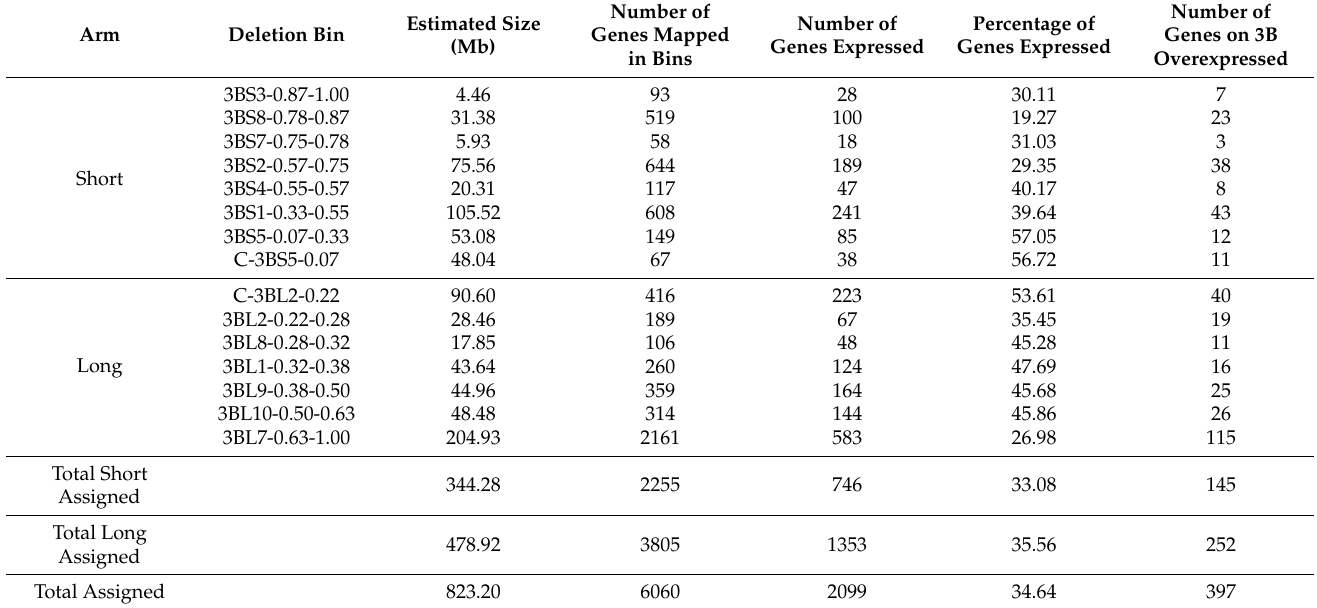
Table 2. Results of expression for the genes assigned to chromosome 3B. Number of genes expressed during meiosis assigned to the different deletion bins of chromosome 3B. Estimated size (Mb): estimated size of each deletion bin; Number of genes mapped in bins: Total number of high confidence (HC) genes mapped per bin; Number of genes expressed: Number of genes expressed (FPKM > 5) per bin; Percentage of genes expressed: associated percentage of expressed genes; Number of genes on 3B overexpressed: number of genes for which the 2 ˆlog2 (Fold Change FPKM) is >2 in both group 3 B–A and B–D comparisons. Genes without homoeologous copies were